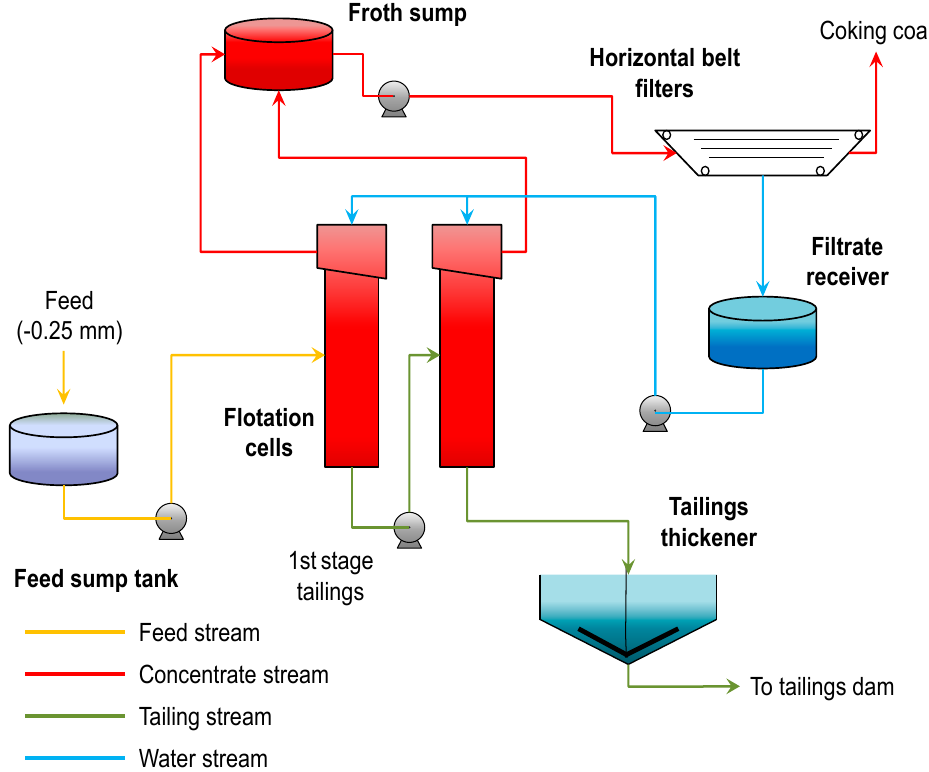
Figure 1. Scheme of the flotation concentration process in the Moatize mine. The average ash content of feed and concentrate is about 21% and 7.5%, respectively.